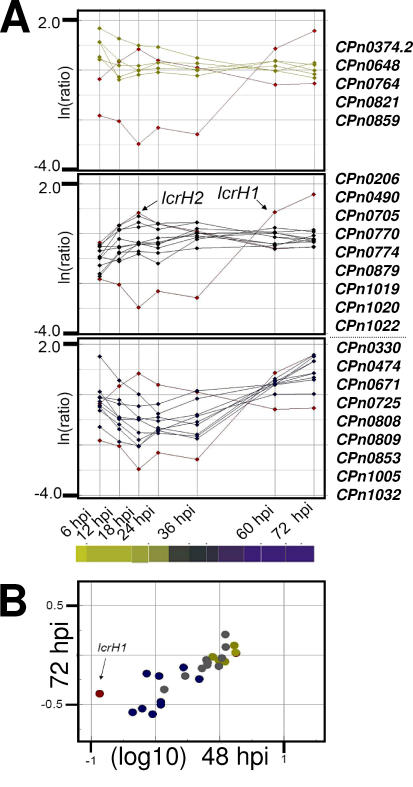
Expression Profiles of Genes Coding for Predicted Putative FactorsThe expression profiles of 24 genes coding for proteins predicted to be type three secreted, [74] as well as the genes coding for the TTSS chaperones LcrH1 and LcrH2, are displayed.(A) According to the expression profiles in the acute developmental cycle, the genes can be grouped into “early”, “mid”, and “tardy” genes. “Mid” gene expression correlated with lcrH2, whereas “tardy” gene expression correlated with lcrH1. This indicates time-dependent functions throughout the cycle. Data are represented as ln(ratio) (y-axis) versus time (x-axis).(B) Comparison plot showing the expression of these 24 genes coding for the predicted TTSS proteins in the iron depletion–mediated persistence. The x-axis represents 48 hpi and the y-axis 72 hpi of the persistent infection. Mainly “tardy” genes are downregulated. Data are displayed as log10. Gene identification numbers, gene definitions, and gene names can be viewed at http://www.ncbi.nlm.nih.gov.